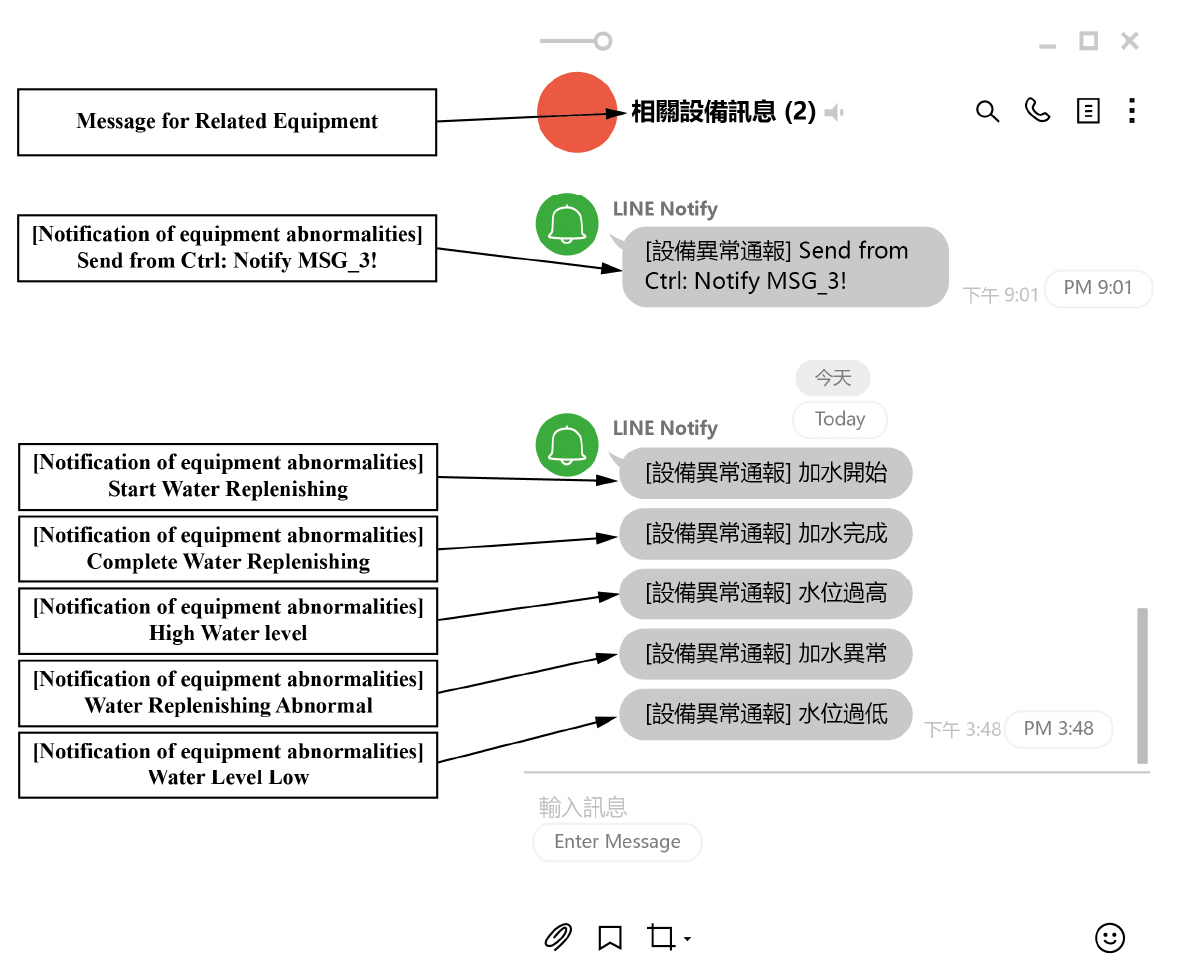
Figure 12. A screenshot of an abnormality message Line Push broadcast function.